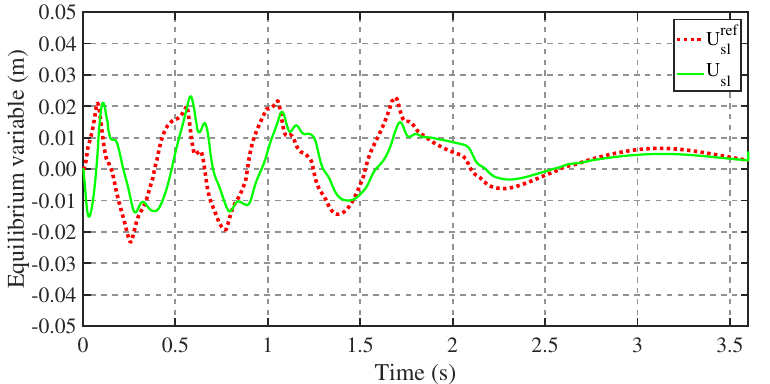
Figure 13. Trajectory of the equilibrium variable when the robot slides on terrain with a variable friction